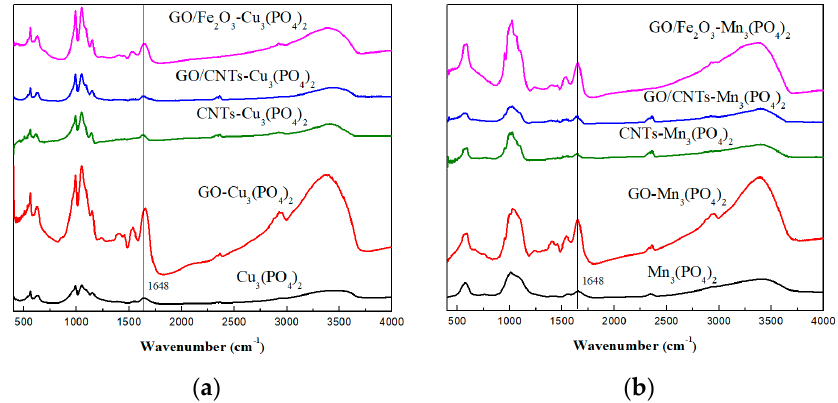
Figure 3. FTIR spectra of: ( a ) Cu 3 (PO 4 ) 2 -based CaLB-HNFs and ( b ) Mn 3 (PO 4 ) 2 -based CaLB-HNFs. Table 1. Correlation coefficient ( r ) between the FTIR spectra of CaLB-HNFs. Nanoflower r